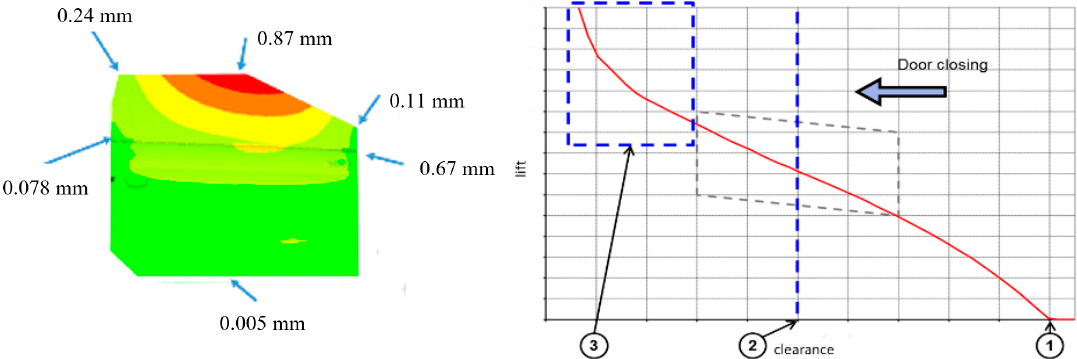
Figure 2. Driver’s door: Generated displacement field ( left ); sealing lift curve versus clearance ( right ).